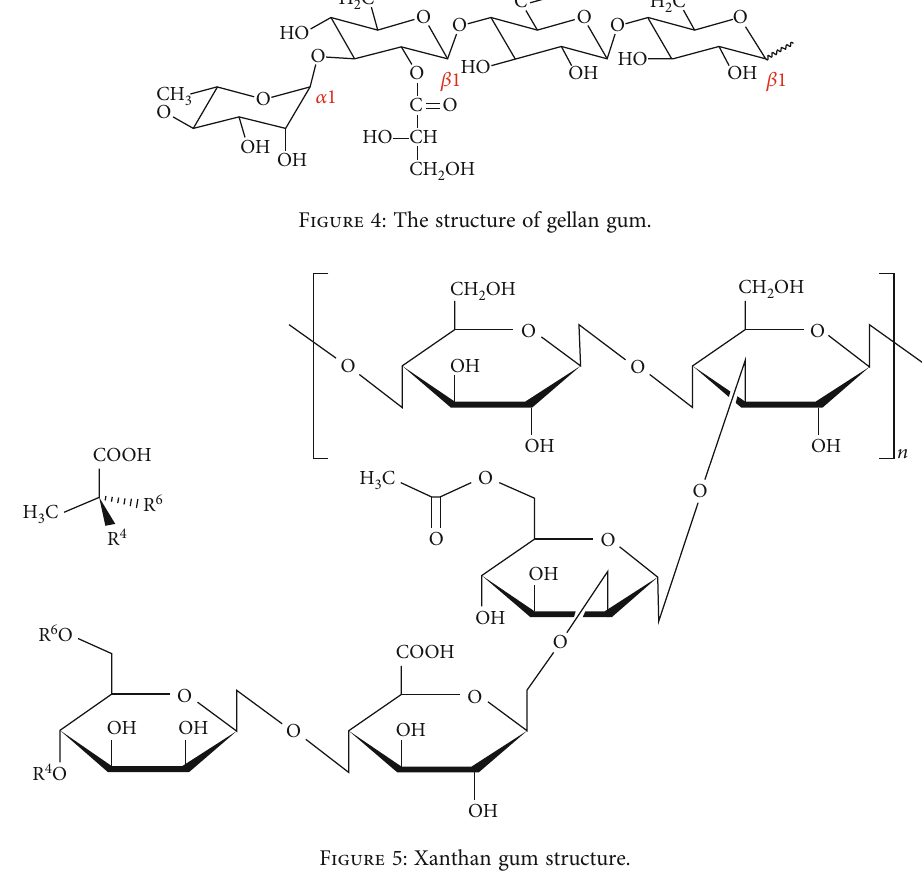
Figure 5: Xanthan gum structure.